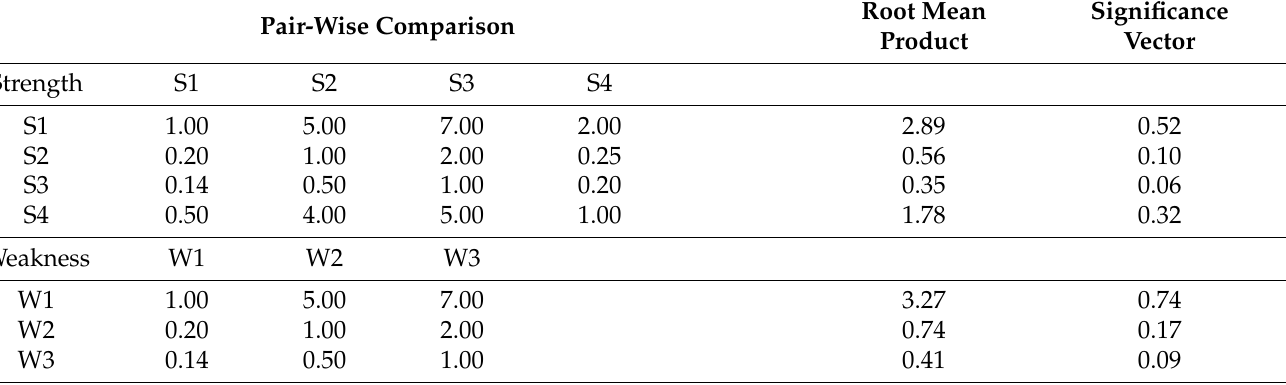
Table 10. Determination of the significance vector of each SWOT factor by the AHP